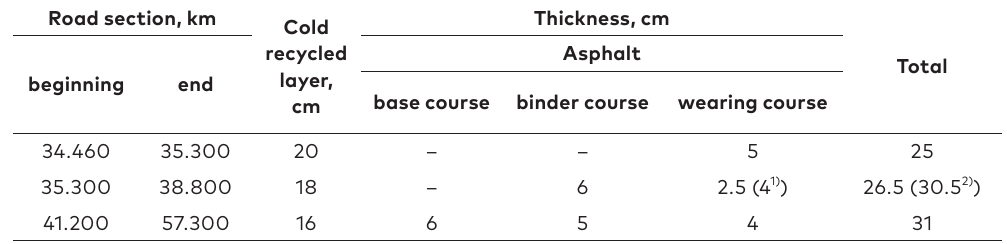
Table 2. Newly constructed pavement structures in road No. A16